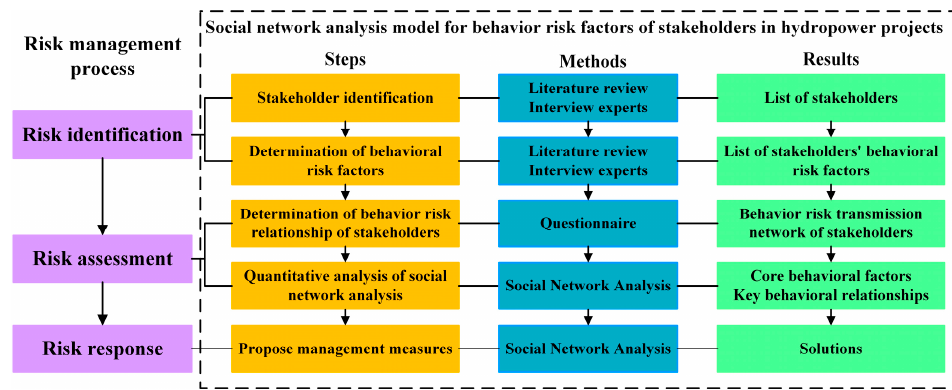
Figure 1. Research model framework.